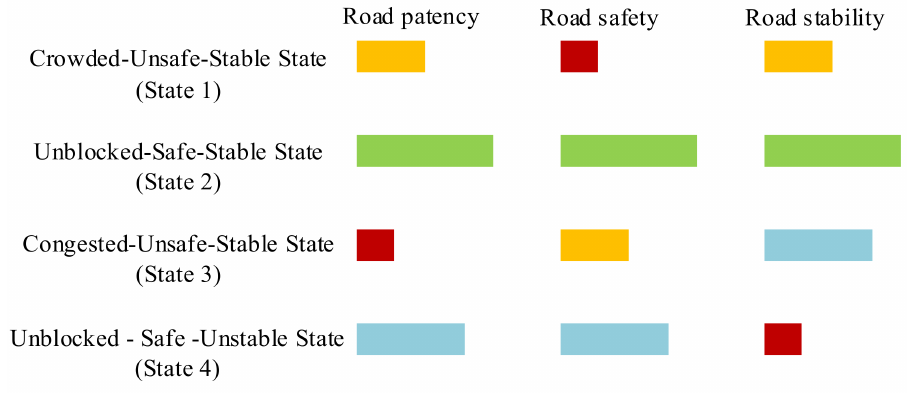
Figure 8. The ranking of the four states on each road evaluation indicator.